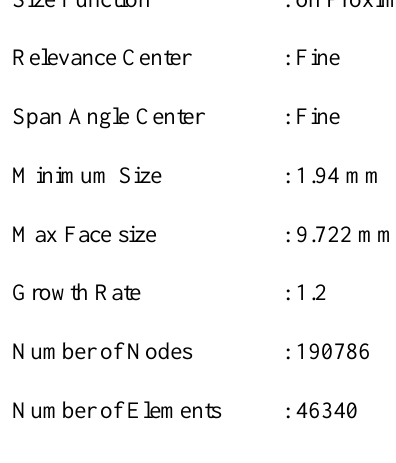
Figure 3 : Thermal Boundary condition for turbine blade